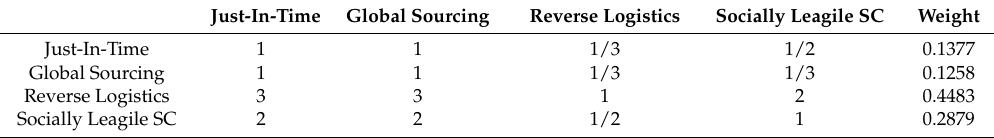
Table A4. Pairwise Comparison of Alternatives w.r.t. sub-criterion Water Pollution. Just-In-Time Global Sourcing Reverse Logistics Socially Leagile SC Weight Just-In-Time